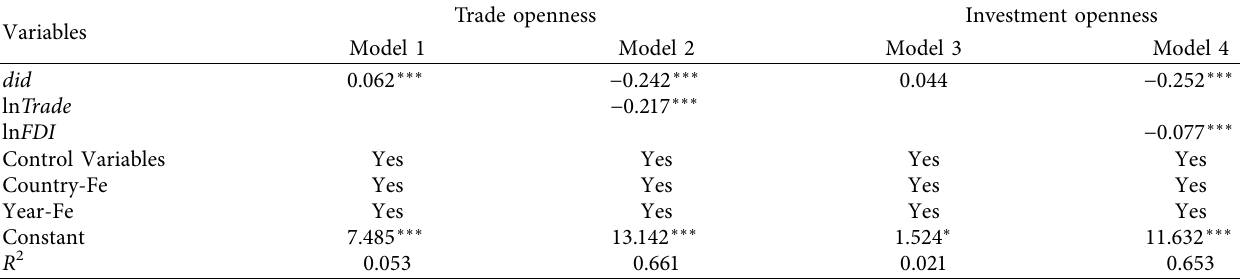
Table 7: Mediation effect test